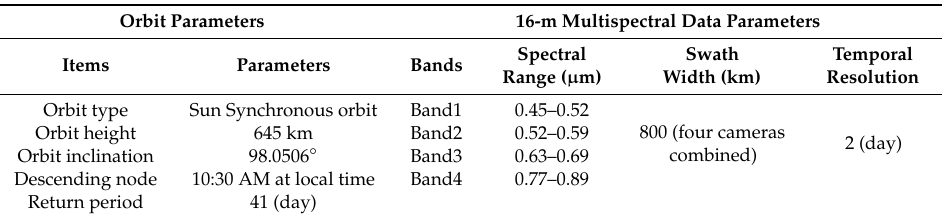
Table 1. The satellite parameters of GF-1.